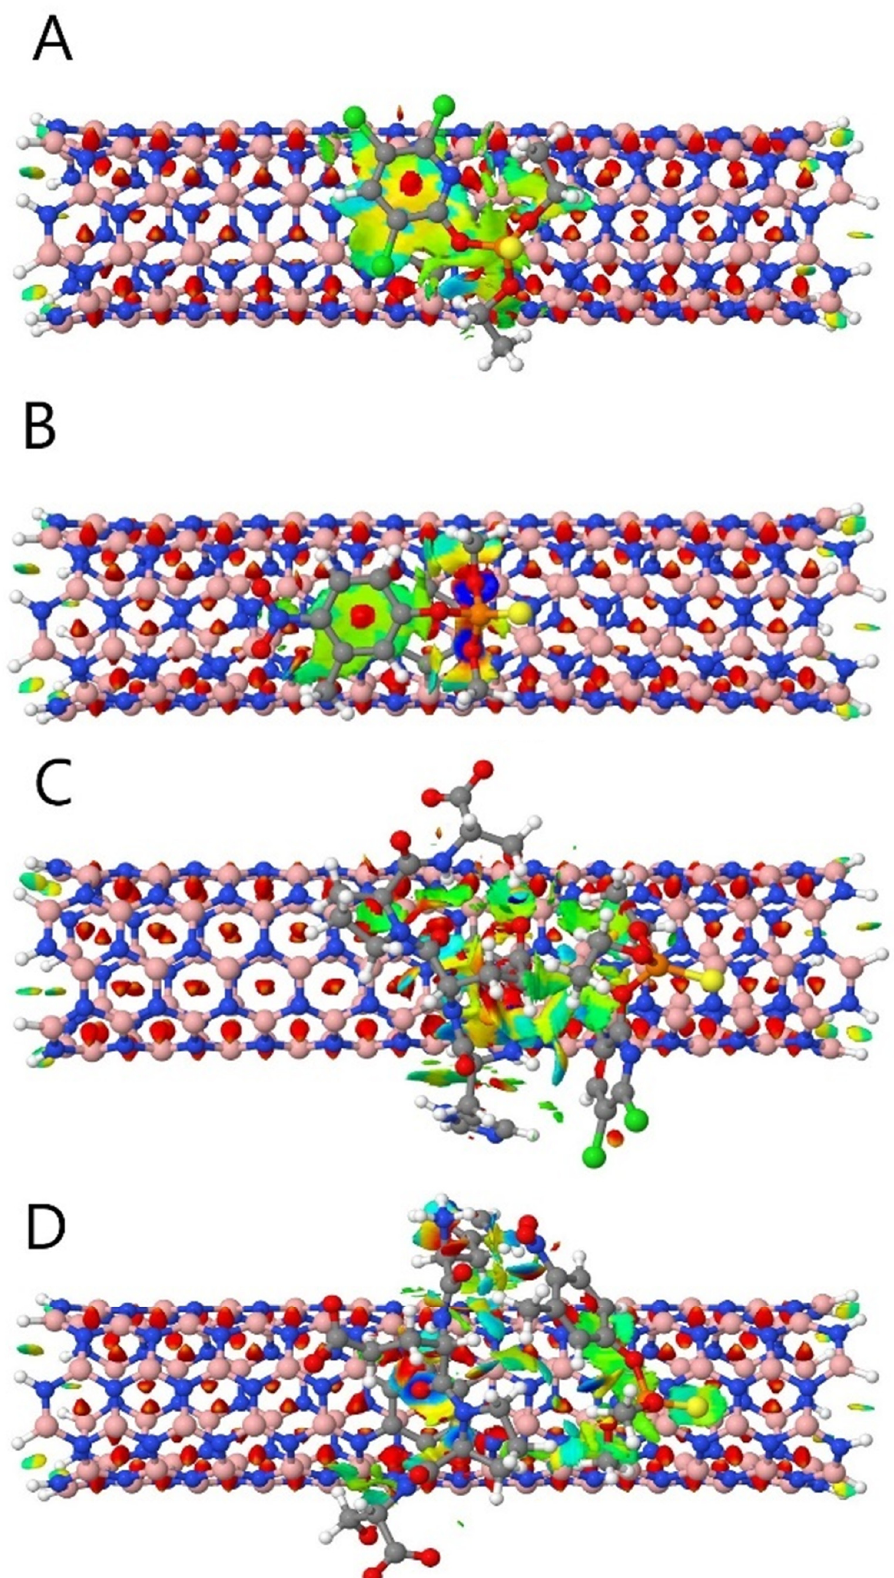
Figure 1. Non-covalent interaction between pesticides (chlorpyrifos (chl) and fenitrothion (fen)) and carbon-doped armchair (5,5) boron nitride nanotube (BN55-CC1) without ( A , B ) and decorated with tetrapeptide (4pep) ( C , D ).